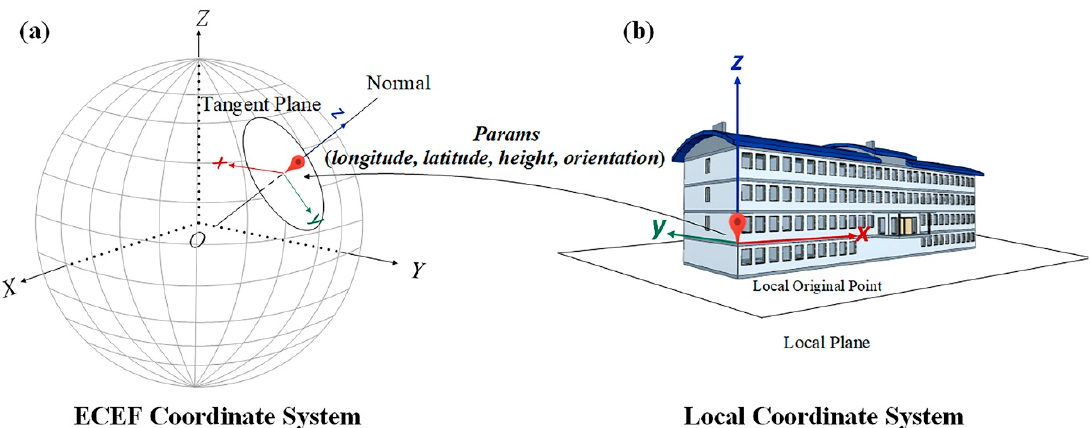
Figure 9. Diagram of geographic location mapping. ( a ) The BIM model at global coordinate system . ( b ) The BIM model at local coordinate system.